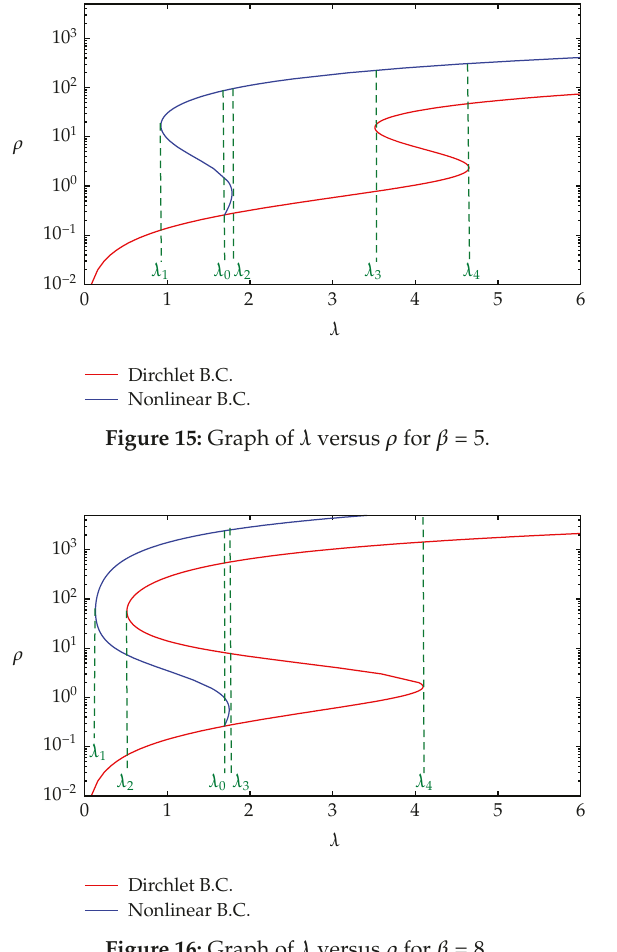
Figure 16 exemplifies Case 4 with the complete bifurcation diagram for β (cid:3) 8.